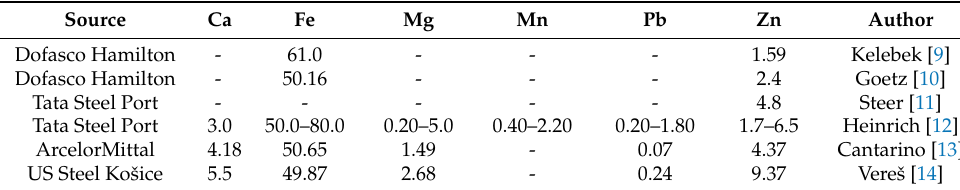
Table 2. Chemical composition of steelmaking sludge